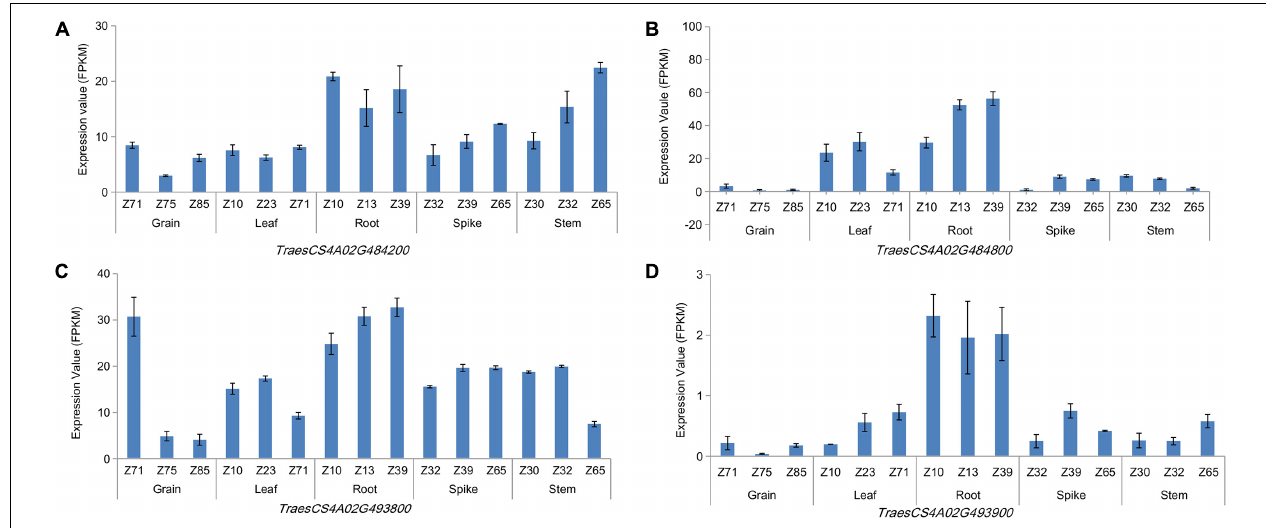
FIGURE 3 | Expression patterns of genes in different wheat organs at three growing stages. TraesCS4A02G484800 (A) , Trae sCS4A02G494200 (B) , TraesCS4A02G 493800 (C) , and TraesCS4A02G493900 (D) .